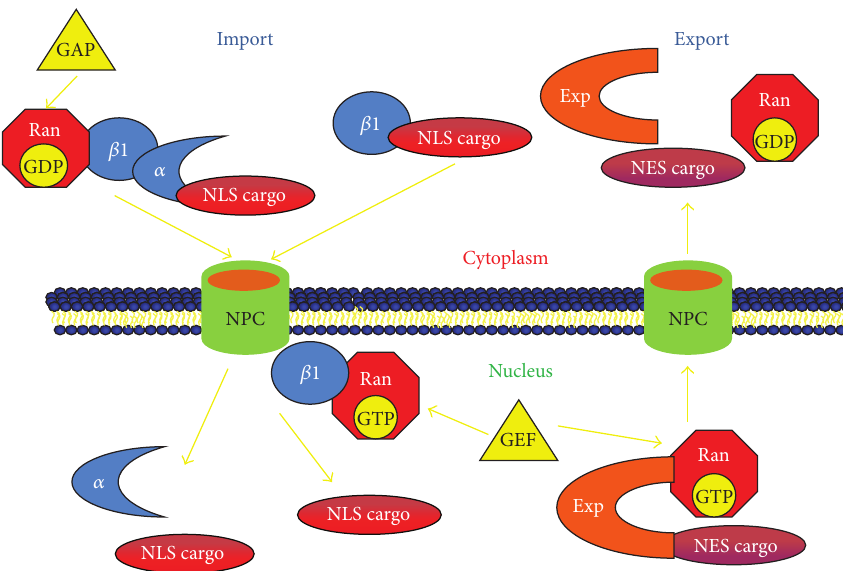
Figure 1: Nucleocytoplasmic transport of macromolecules via importin-exportin pathway. In the cytoplasm, importin- 𝛼 forms a heterotrimeric complex with importin- 𝛽 1, RanGDP, and NLS containing cargo protein. This heterotrimeric complex passes through the NPC into the nucleus and RanGTP binds to importin- 𝛽 1 and disassembles the complex in the nucleus. The binding of exportin to NES within the cargo protein is triggered by RanGTP in the nucleus and is exported back to the cytoplasm through nuclear pore complex (NPC). In the cytoplasm, the dissociation of the complex is mediated through the hydrolysis of RanGTP to RanGDP by GAP (GTPase activating protein) that forces the binding of GDP to Ran. GEF (guanine nucleotide exchange factor) is a nucleoplasmic factor that stimulates exchange of GDP with GTP forming RanGTP in the